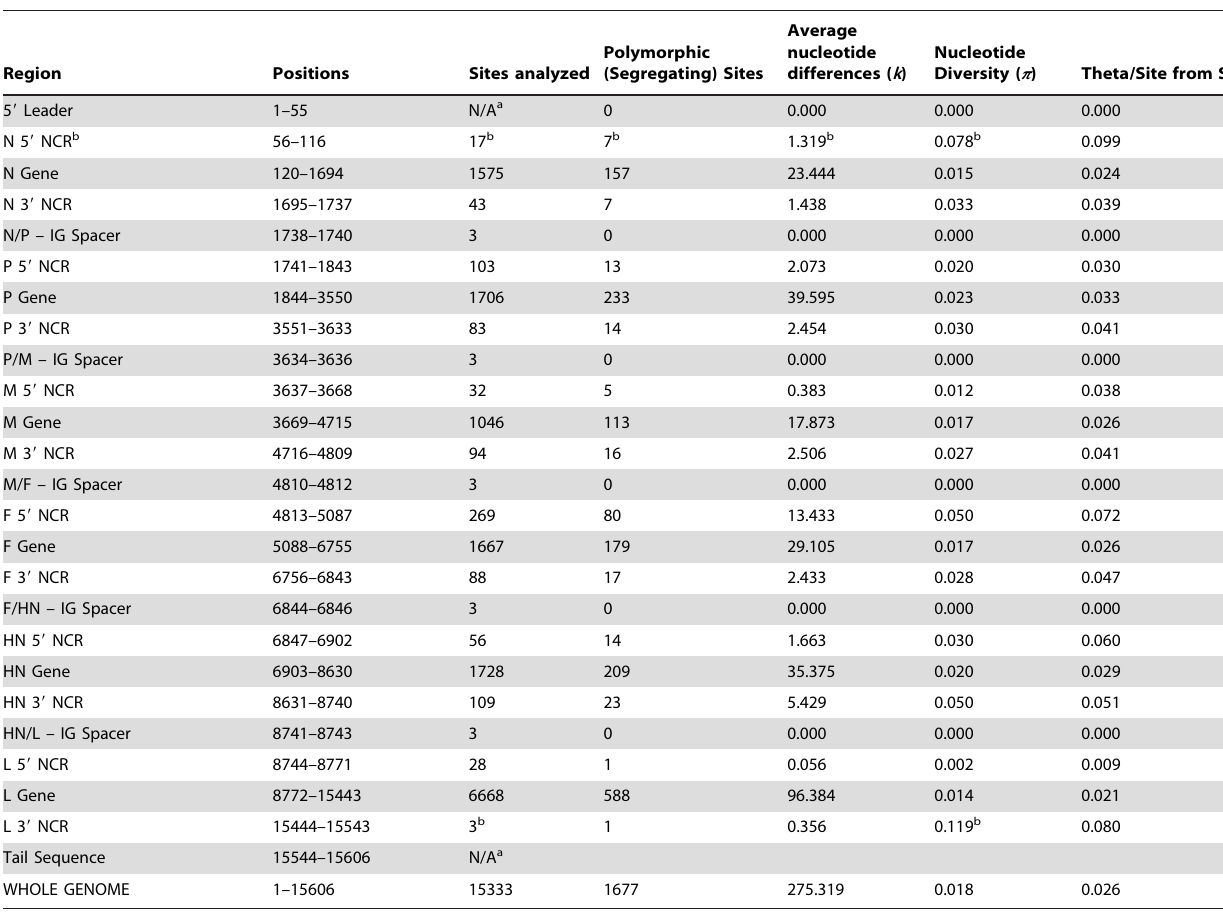
Table 5. Genetic Diversity Across the HPIV-1 Genome.